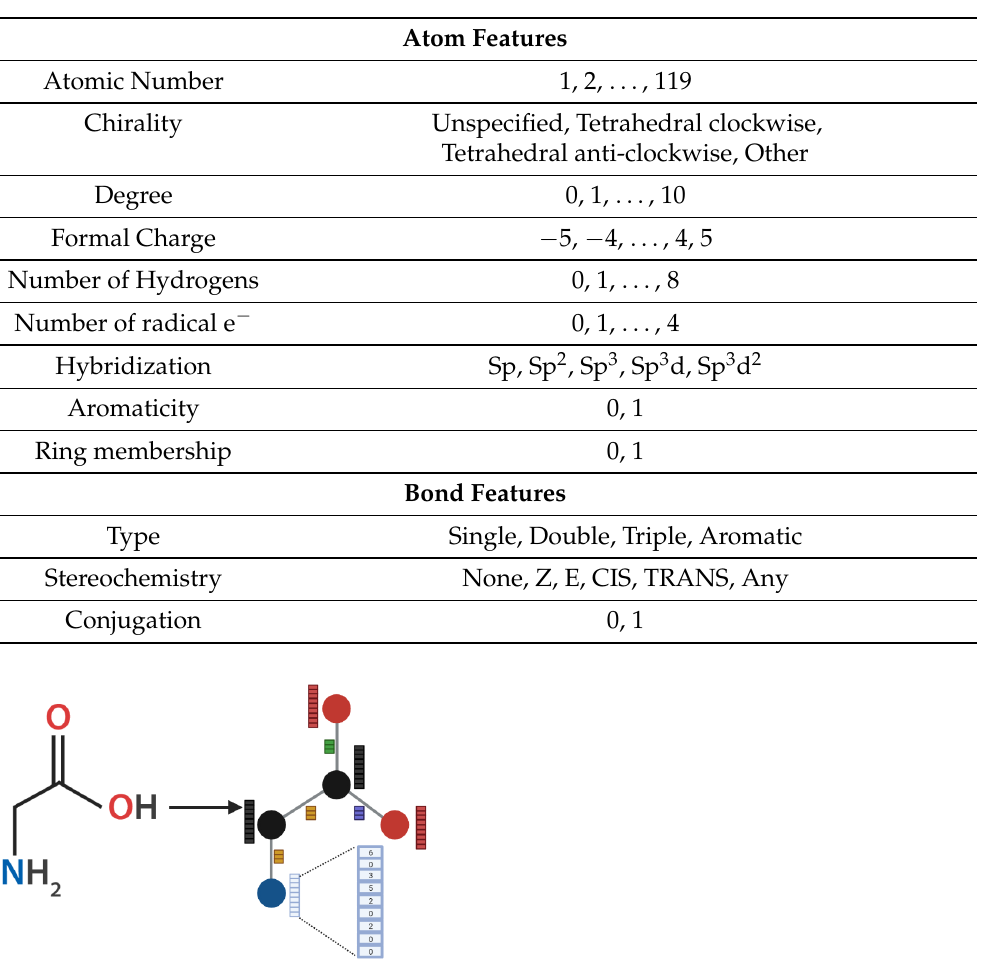
Table 3. Atom and bond features description. Feature vectors were obtained with the aid of the RdKit and OGB libraries, which describe the state of an atom and a bond within a molecule.